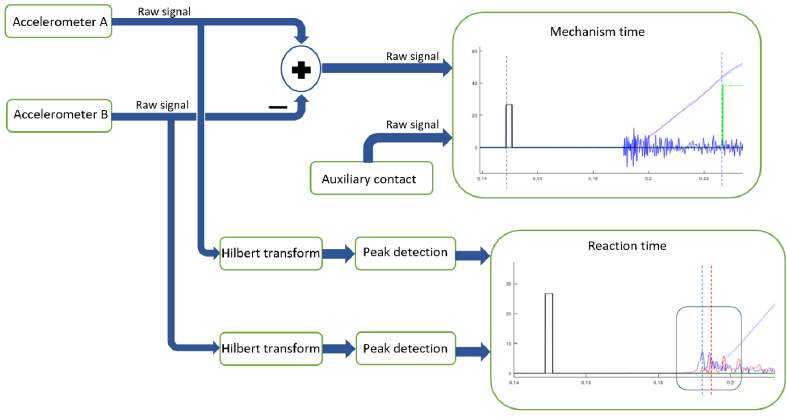
Figure 12. Flowchart with the processing steps of the acceleration signals to obtain the HVCB mechanism and reaction